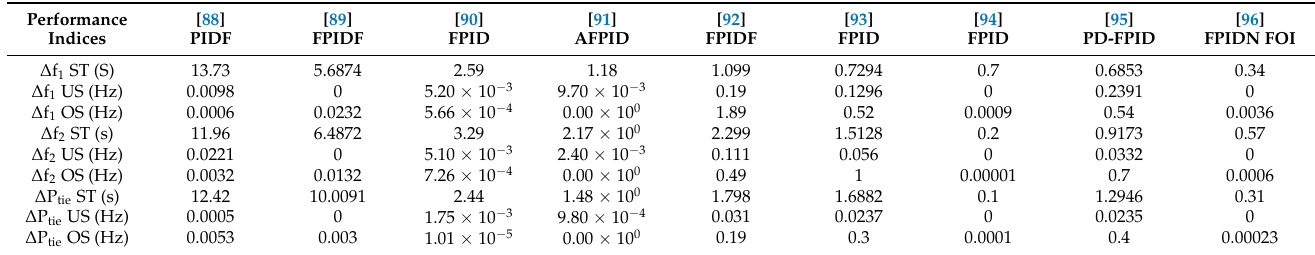
Table 3. Performance Indices of Fuzzy Controller in an Interconnected Power System.